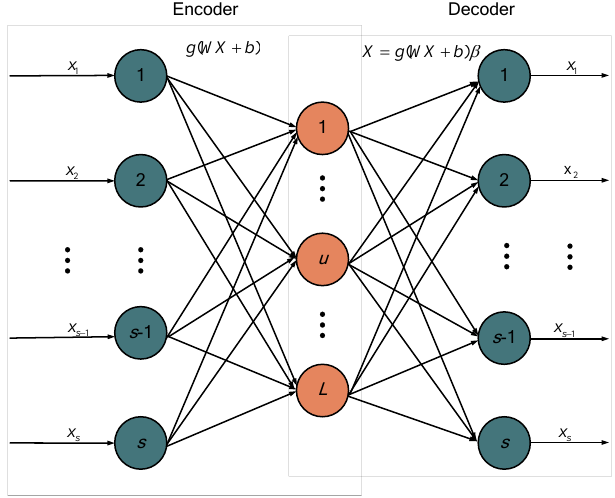
Figure 1. The Structure of AE-ELM.